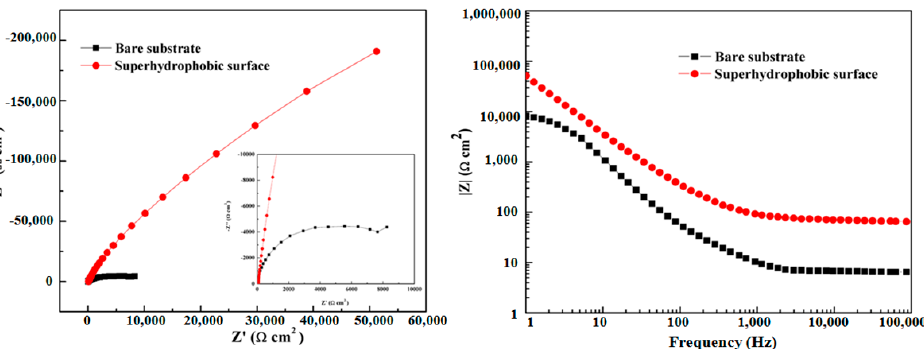
Figure 8. Nyquist plots and Bode plots of bare AA5052 aluminum alloy and superhydrophobic surface in 3.5 wt.% NaCl solution.